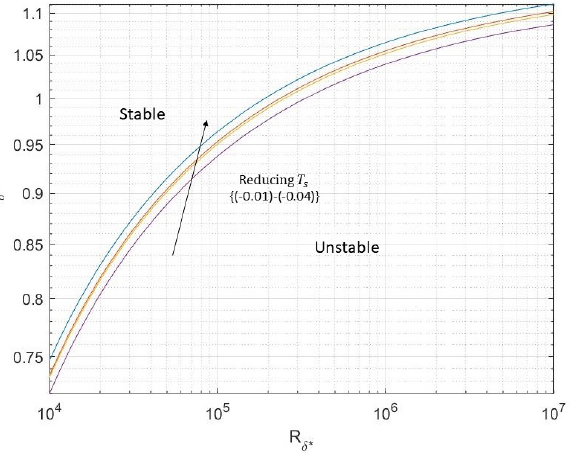
Figure 13. Plot illustrating predictions of asymptotic neutral wavenumber γ δ ∗ against R δ ∗ for type I modes for T s = ( − 0.01 ) − ( − 0.04 ) . Smaller T s values move the plots up as shown by the